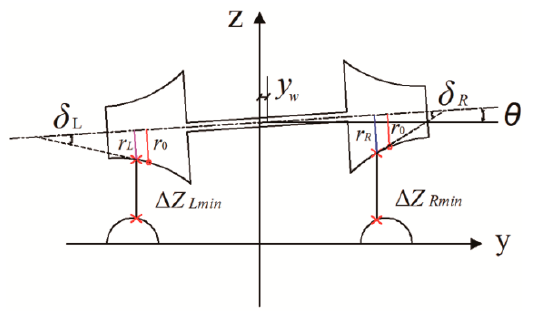
Figure 1. Wheel-rail contact.